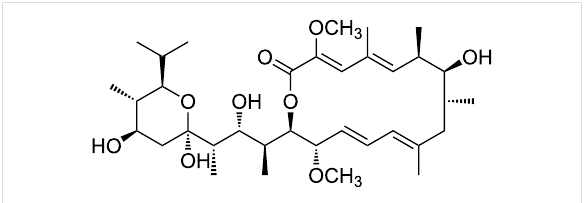
Figure 3: Structure of bafilomycin A 1